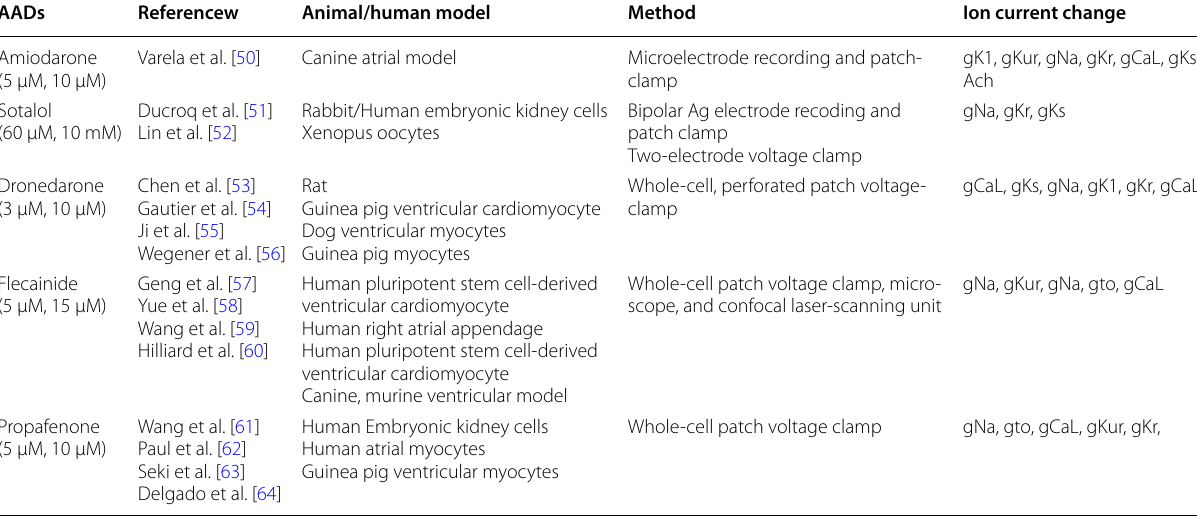
Table 2 References for atrial cell ion currents depending on AADs